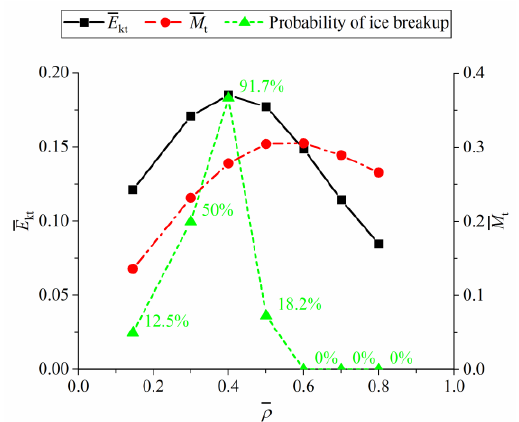
Figure 18. The relationship between E kt , M t and the probability of the ice breakup with the relative density obtained in experiments.